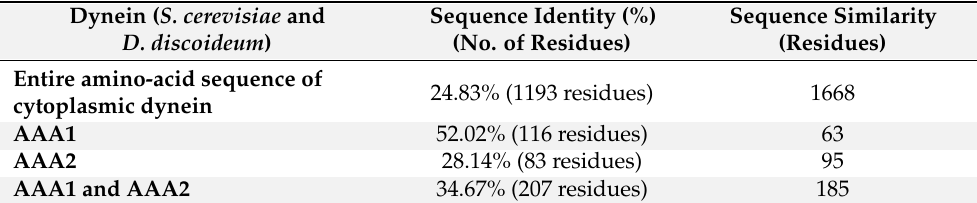
Table 2. Amino-acid sequence identity and similarity of the different parts of dynein, between S. cerevisiae and D. discoideum